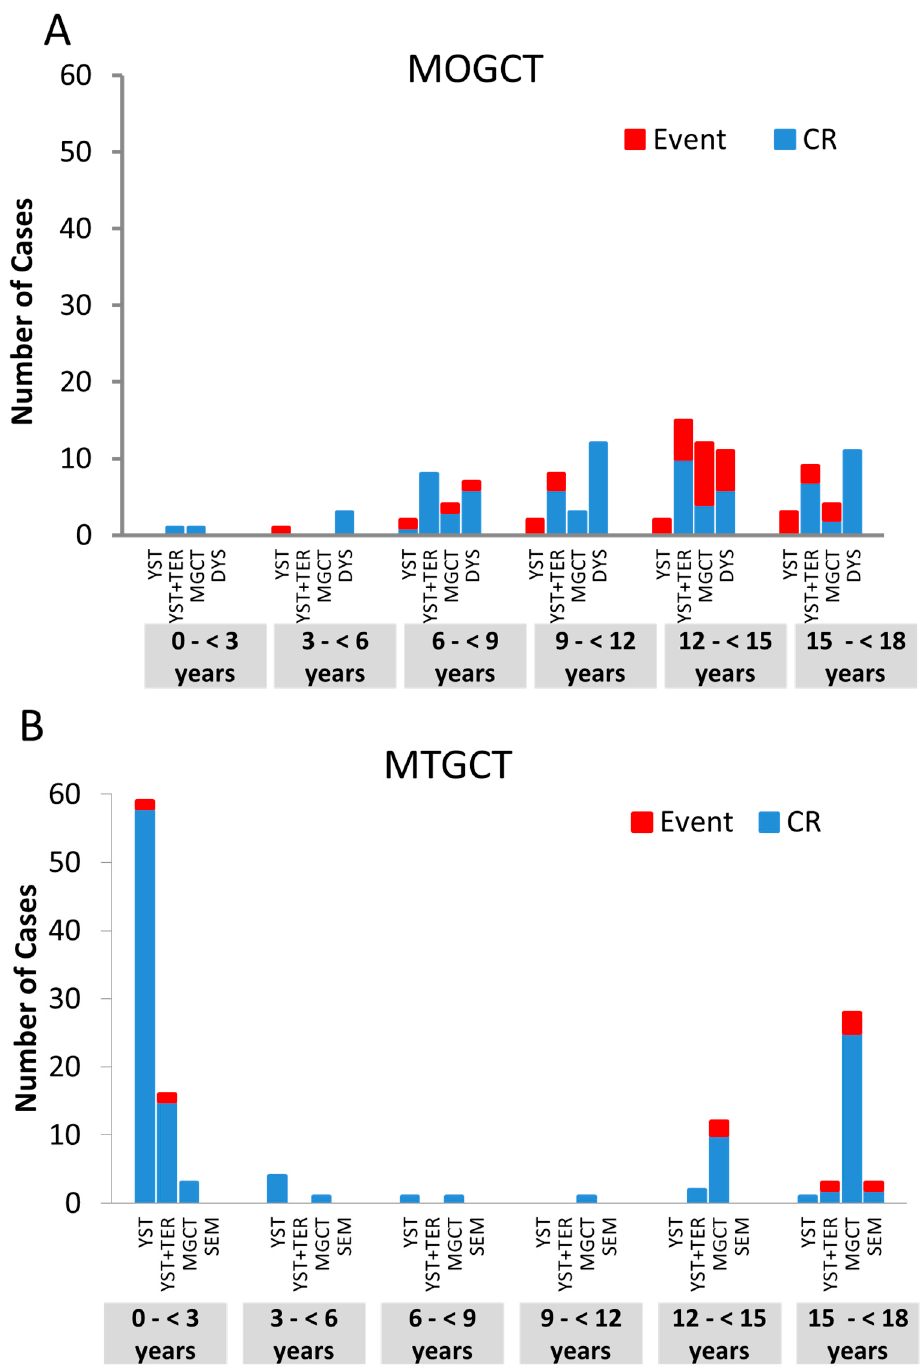
Figure 3. Outcome in stage I patients undergoing w&w strategy, Events (red column) are presented in respect to age and the histologic subentities. ( A ) Events in 137 FIGO stage I patients undergoing w&w strategy with malignant ovarian germ cell tumors (MOGCT): 46 Events are presented in respect to age and the histologic subentities. In MOGCT, higher age correlates with a higher progression rate, this difference is significant. Furthermore pure YST histology was associated with a high risk of progression; ( B ) Events in 103 Lugano stage I patients undergoing w&w strategy with malignant testicular germ cell tumors (MTGCT): 12 Events are presented in respect to age and the histologic subentities. In MTGCT, no age and histology specific trends were observed.